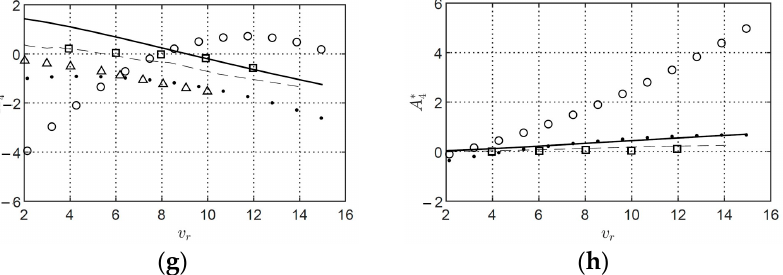
Figure 26. Comparison of aerodynamics derivatives from 2DOF test for Setup 1. (o) Polynomial fit from pitch using MITD method, (…) polynomial fit from heave using MITD method, ( □ ) wind tunnel test (Larsen et al.) [42], ( ∆ ) wind tunnel test [2], ( − − ) water channel tests, (—) flat plate by Theodorsen. ( a ) 𝐻 (cid:2869)∗ ; ( b ) 𝐴 (cid:2869)∗ ; ( c ) 𝐻 (cid:2870)∗ ; ( d ) 𝐴 (cid:2870)∗ ; ( e ) 𝐻 (cid:2871)∗ ; ( f ) 𝐴 (cid:2871)∗ ; ( g ) 𝐻 (cid:2872)∗ ; ( h ) 𝐴 (cid:2872)∗ .